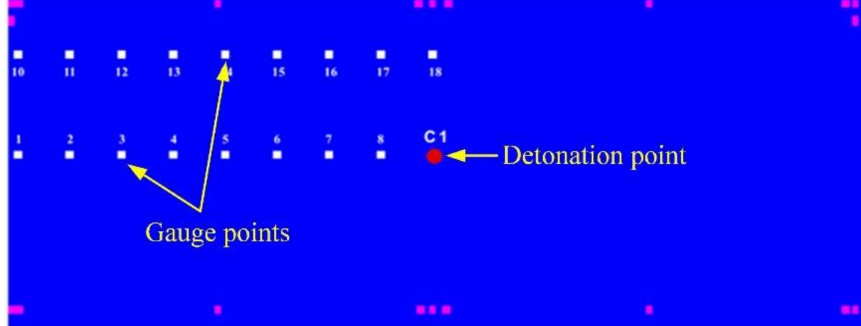
Figure 11. Initiation point and gauge point